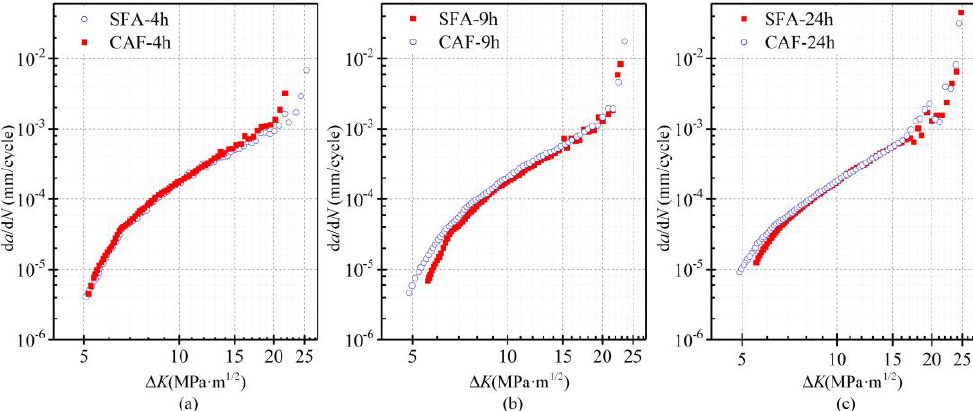
Figure 10. Comparison of the fatigue crack propagation (FCP) rates of creep aged and stress-free aged AA2524 for various aging times: ( a ) 4 h; ( b ) 9 h; ( c ) 24 h.